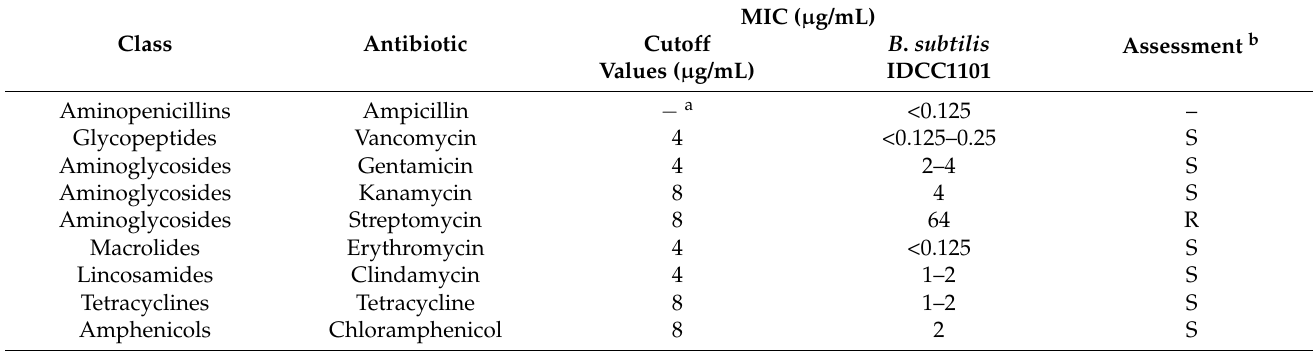
Table 6. Minimum inhibitory concentration and antibiotic susceptibility of B . subtilis IDCC1101.